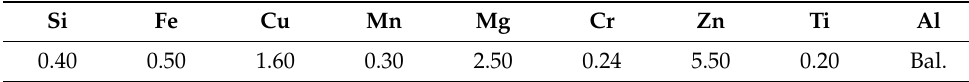
Table 1. Chemical composition of the test material (wt%).